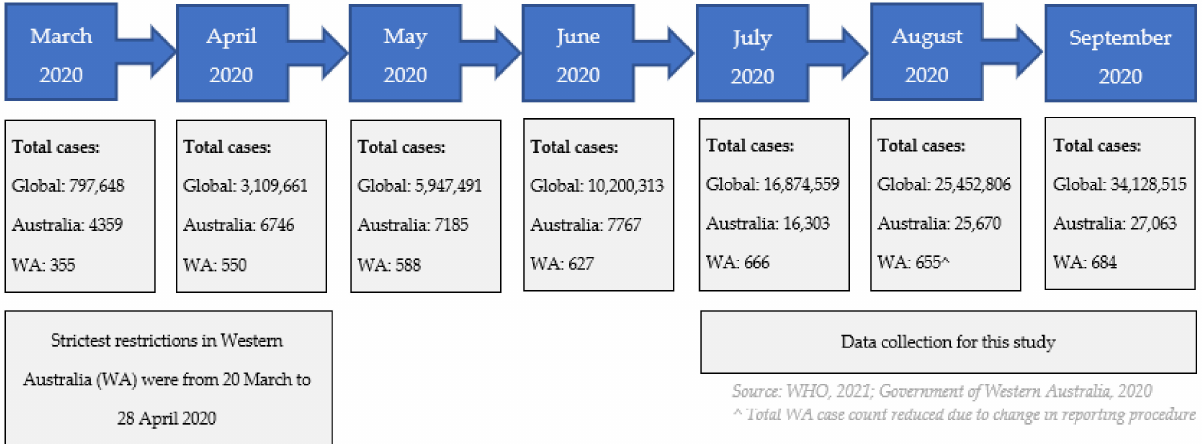
Figure 2. Total COVID-19 case numbers at the end of each month, key time-points and study